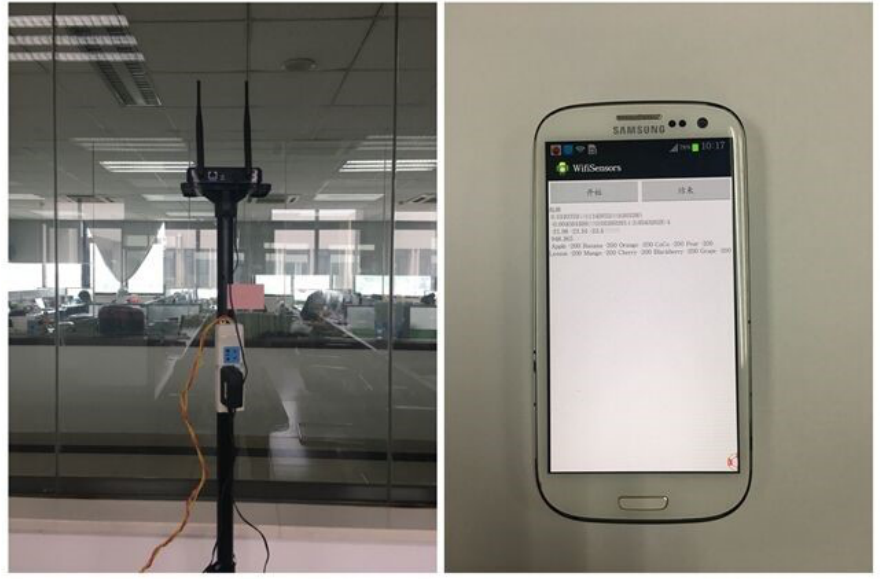
Figure 7 . WiFi AP and a mobile phone for the test